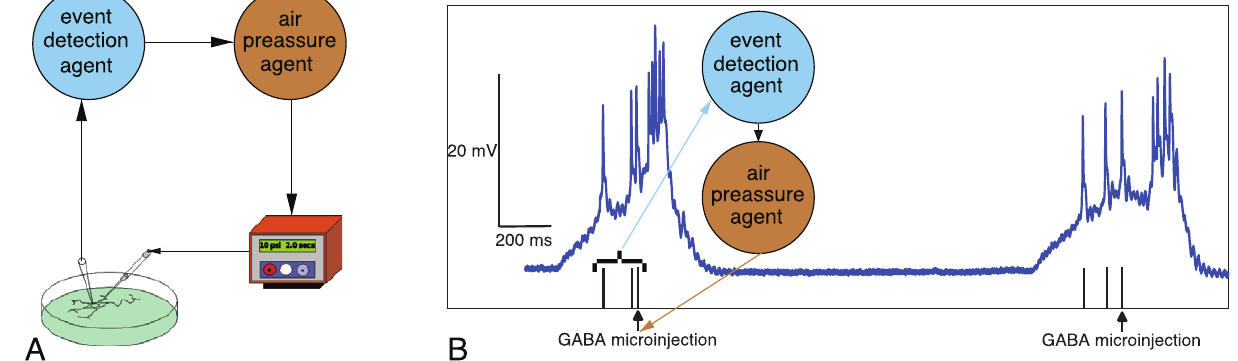
Figure 3. Activity-dependent drug microinjection. Panel A shows a schematic representation of the closed-loop drug stimulation protocol. In this example, the membrane potential of a neuron is monitored by an event detection algorithm to perform the activity-dependent drug microinjection. When an event is detected, the software sends a signal to the microinjector and the neurotransmitter or neuromodulator is released. Panel B shows the real time (RT) stimulation protocol we employed in the experiments discussed in this section. This adaptive protocol consists of a double 1 mM GABA injection (two 40 ms pulses separated by 30 ms) when the third spike is detected at the beginning of a burst of a cardiac neuron (vertical lines indicate the detection of single spikes, arrows indicate the instant in which the microinjection takes place). The resulting inhibitory closed-loop is used to achieve a desired number of spikes in the bursting activity of these neurons.